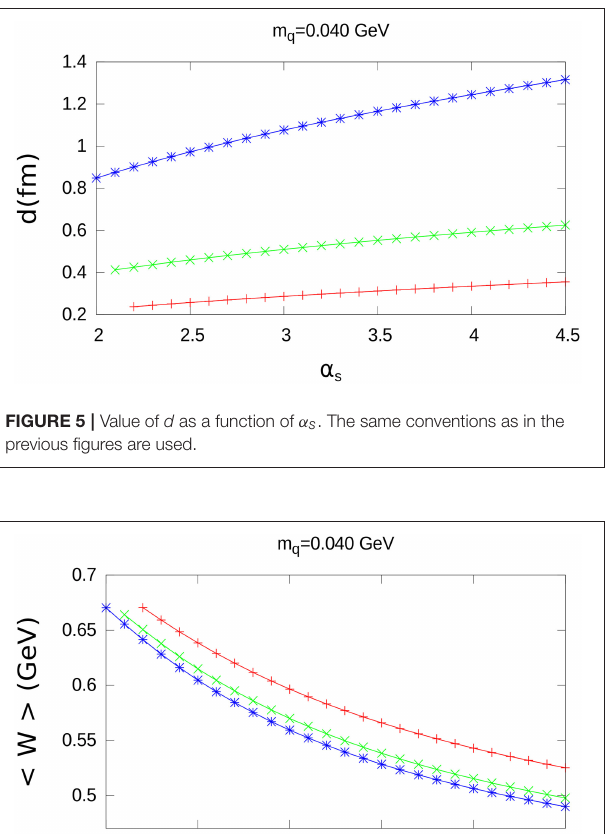
the “unperturbed“ value M qqq ground state mass to be